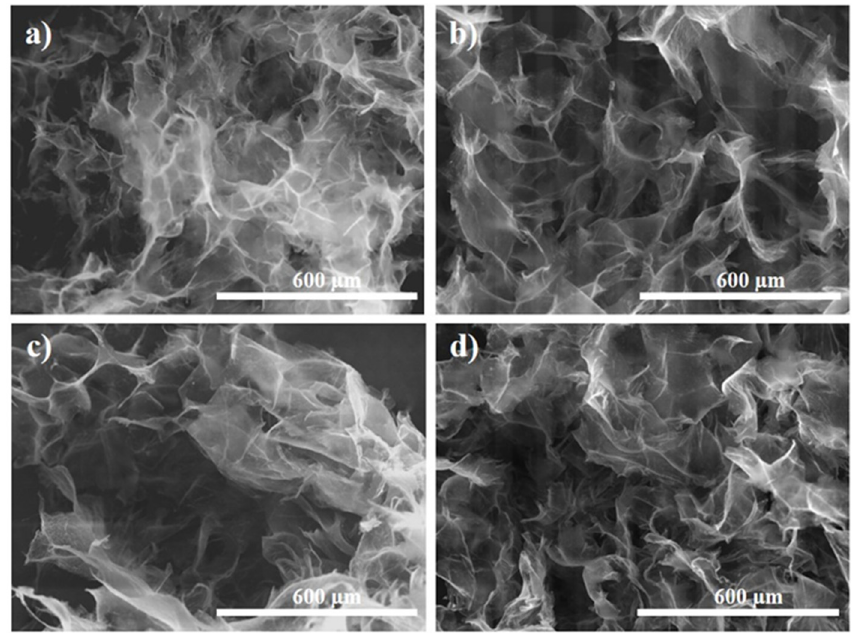
Figure 4. SEM images of PAMAM-modified rGO aerogels: G3 (0.6 mg mL − 1 ) at T HT of ( a ) 110 °C and ( b ) 140 °C and with G7 (0.2 mg mL − 1 ) at T HT of ( c ) 110 °C and ( d ) 140 °C. and ( b ) 140 ◦ C and with G7 (0.2 mg mL − 1 ) at T